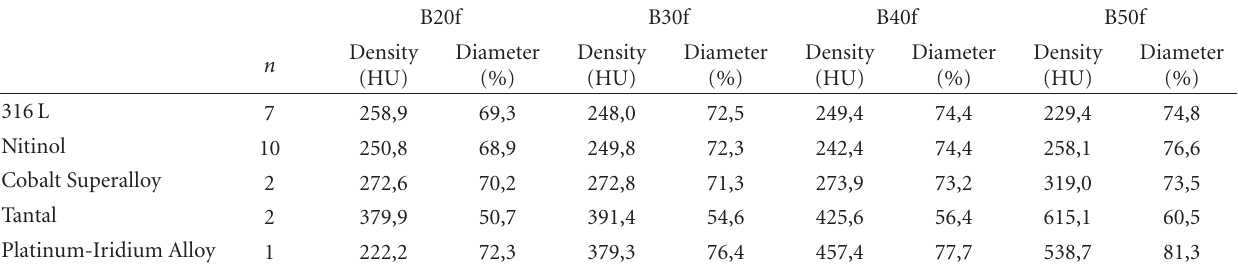
Table 3: Mean visible lumen diameters and lumen attenuation in the di ff erent reconstruction protocols depending on the stent